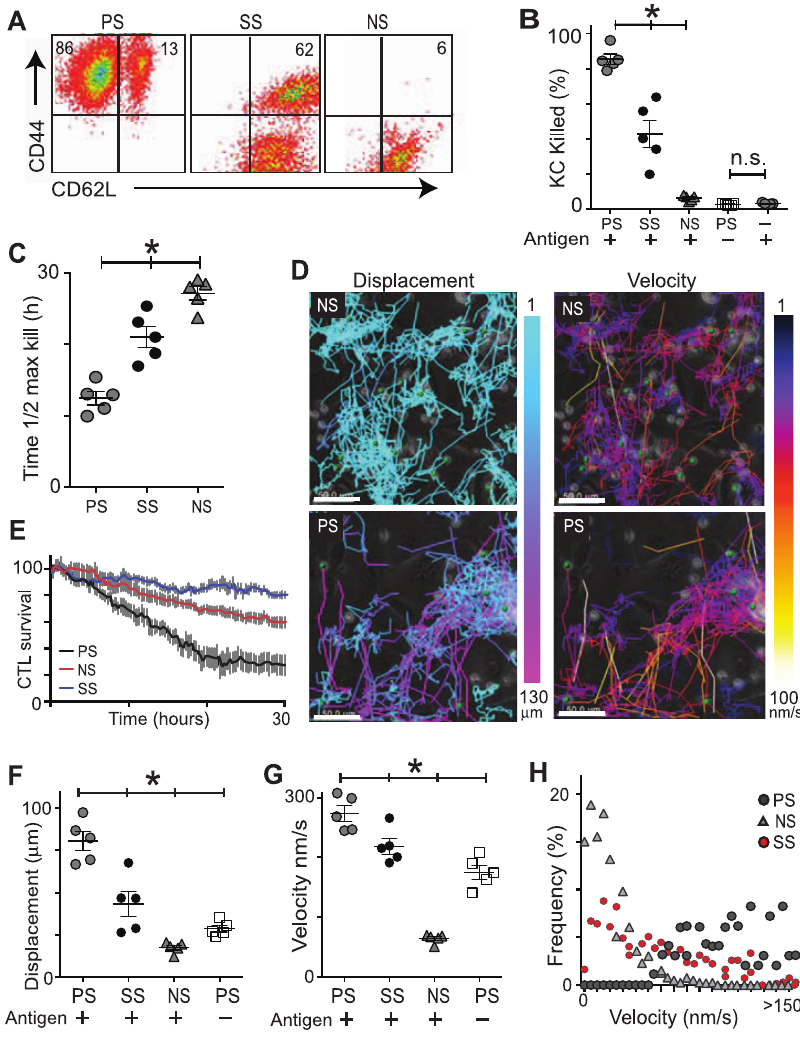
Figure 6. Kinematics of activated CD8 + T cells correlate with their cytotoxicity. CD8 + T cells were generated by prolonged stimulation (PS) of splenocytes from OVA-immunised mice with irradiated feeder cells pulsed with 0.1 mg.ml 2 1 peptide, or they underwent short stimulation (SS) by overnight culture with 1 mg.ml 2 1 of peptide; or they were not stimulated (NS) in vitro after immunization. These were added to cultured KC targets presenting SIINFEKL and imaged. A . T cells were isolated by FACS based on size, granularity, EGFP and CD8 expression. These CD8 + cells were then stained for CD44 and CD62L expression. B . Percentage of KC targets that were killed by each group of CTL over a 30 hour time-course is shown. PS T cells were also added to KC without peptide to show non-specific killing. Death rate of KC in monoculture is also shown. C . The time for each group of T cells to reach 50% of their total target cell death is shown. (N=3 independent experiments) D . Examples of the movement tracks taken by CTL among the KC cells colour-coded for displacement and velocity. Scale bars, 50 m m. E . Survival of PS, NS and SS CTL over 30 hours of co-culture with antigen-loaded KC was determined from the number of GFP + cells remaining as imaging progressed, as a percentage of the total number of GFP + cells at time 0. Pooled data 5 experiments, error bars are SD. F. & G . Displacement and velocity of effector cell groups in culture with targets with and without antigen. (B, C, F, G N=5, error bars SEM) H . Example of frequency plot of velocity values for the different populations of CTL. (*p , 0.05 between indicated groups, n.s. not significant,